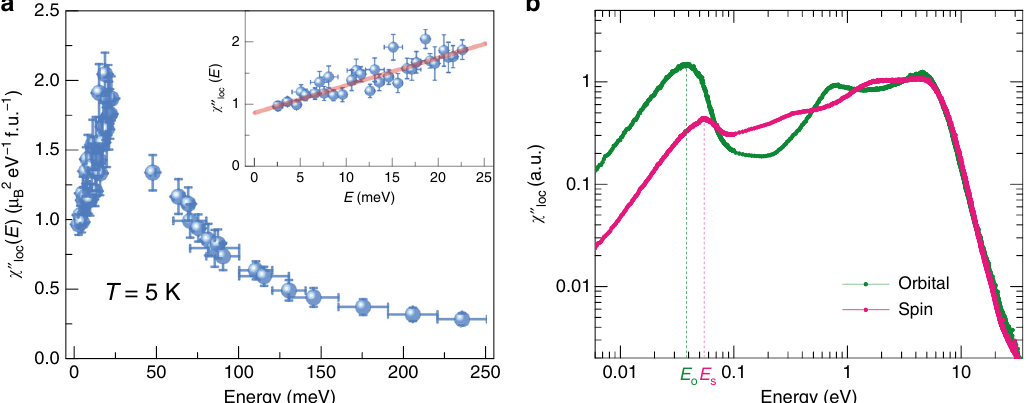
Fig. 4 Local susceptibilities for MnSi. a Local magnetic susceptibility determined via inelastic neutron scattering data plotted as a function of energy. The inset shows the low-energy region (below 25 meV) and the linear dependence well below the peak near 30 meV. b Local Mn susceptibility calculated via DFT + DMFT calculations for both orbital (green line) and spin (maroon line). Vertical dashed lines mark peaks above which coherence is lost in both the orbital and spin sectors. Error bars represent one standard deviation of the